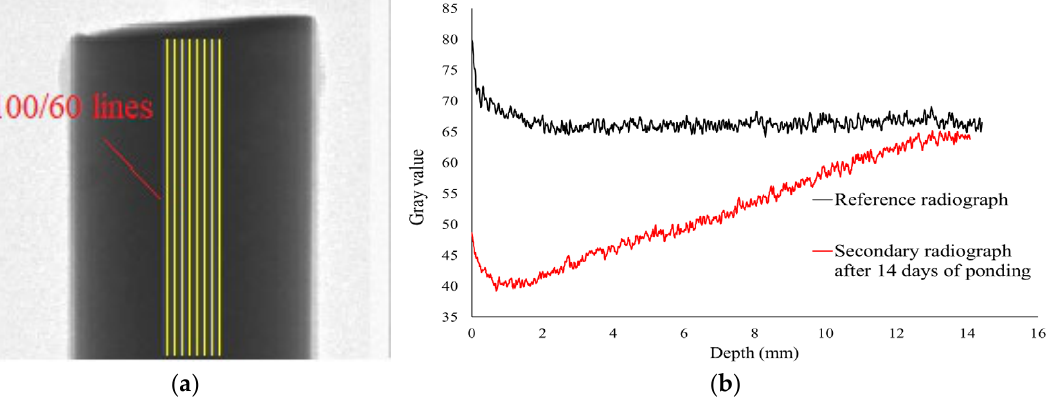
Figure 7. ( a ) Radiograph with a considered region in data analyzing and ( b ) averaged gray value profiles.